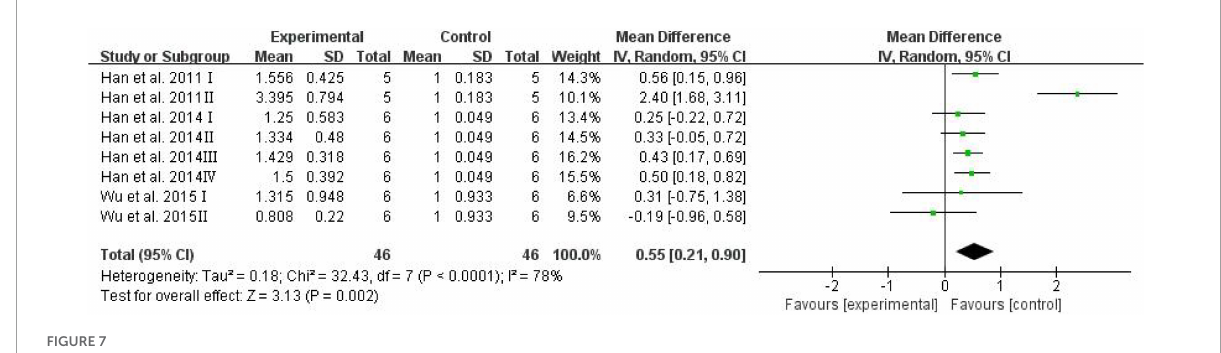
FIGURE7 Forest plot of the brain